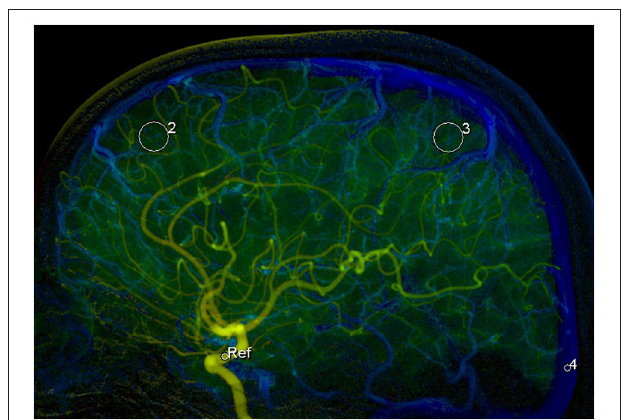
FIGURE 1 | Selection of the 4 regions of interests (ROIs) in the lateral phase of colored blood flow image: 1, the ROI with areas of 2.4 mm 2 at the ophthalmic segment of the internal carotid artery (ICA); 2, the ROI with areas of 42.6 mm 2 at frontal lobe; 3, the ROI with areas of 42.6 mm 2 at parietal lobe; and 4, the ROI with areas of 2.4 mm 2 at superior sagittal sinus at the 2cm above the confluence of the